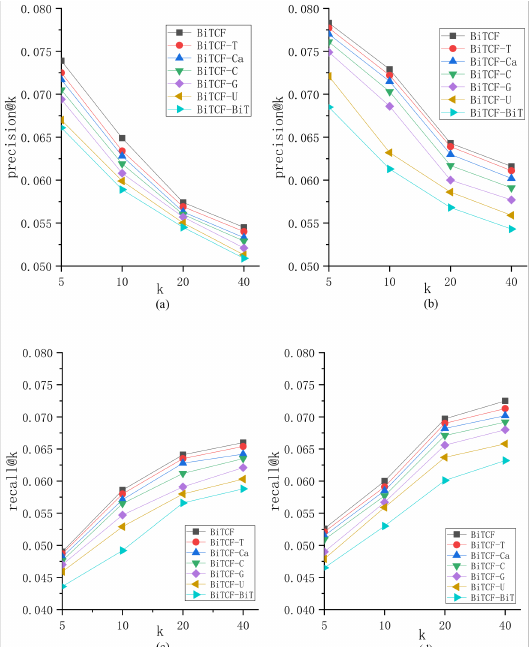
Figure 2. Comparison of different factor contributions: ( a , c ) on Gowalla; ( b , d ) on